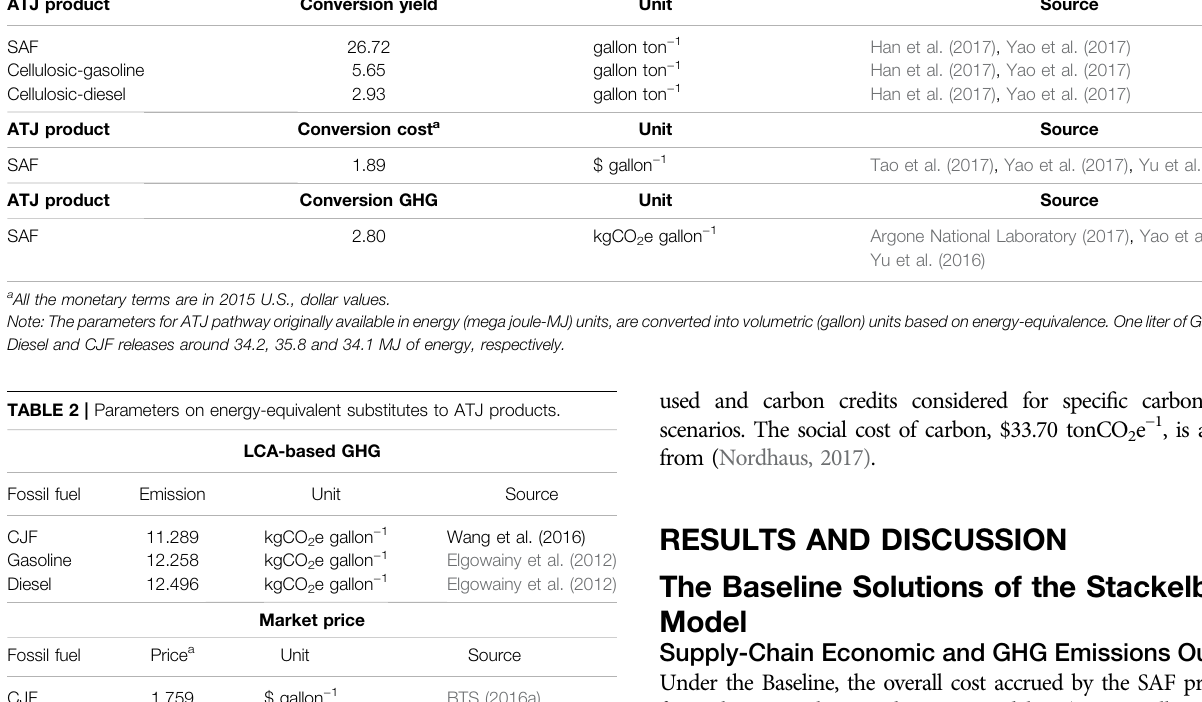
TABLE 1 | Parametric assumptions for cellulosic alcohol-to-jet (ATJ) conversion pathway. ATJ product